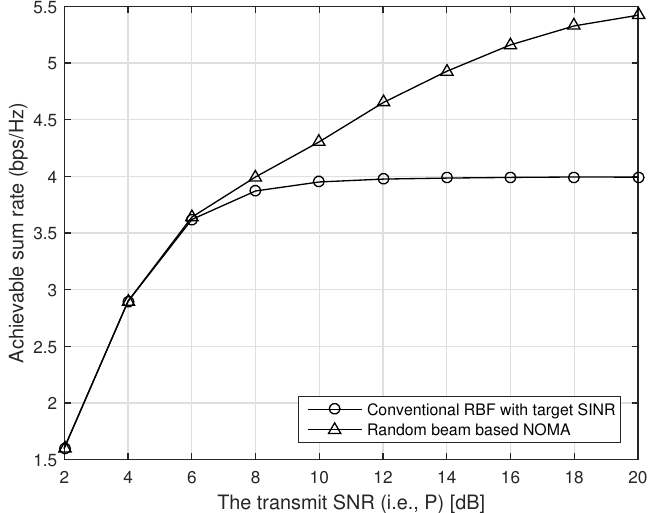
Figure 3. The performance of our proposed random beam-based NOMA with respect to the transmit SNR when the transmitter has four antennas, and the number of users is 50.